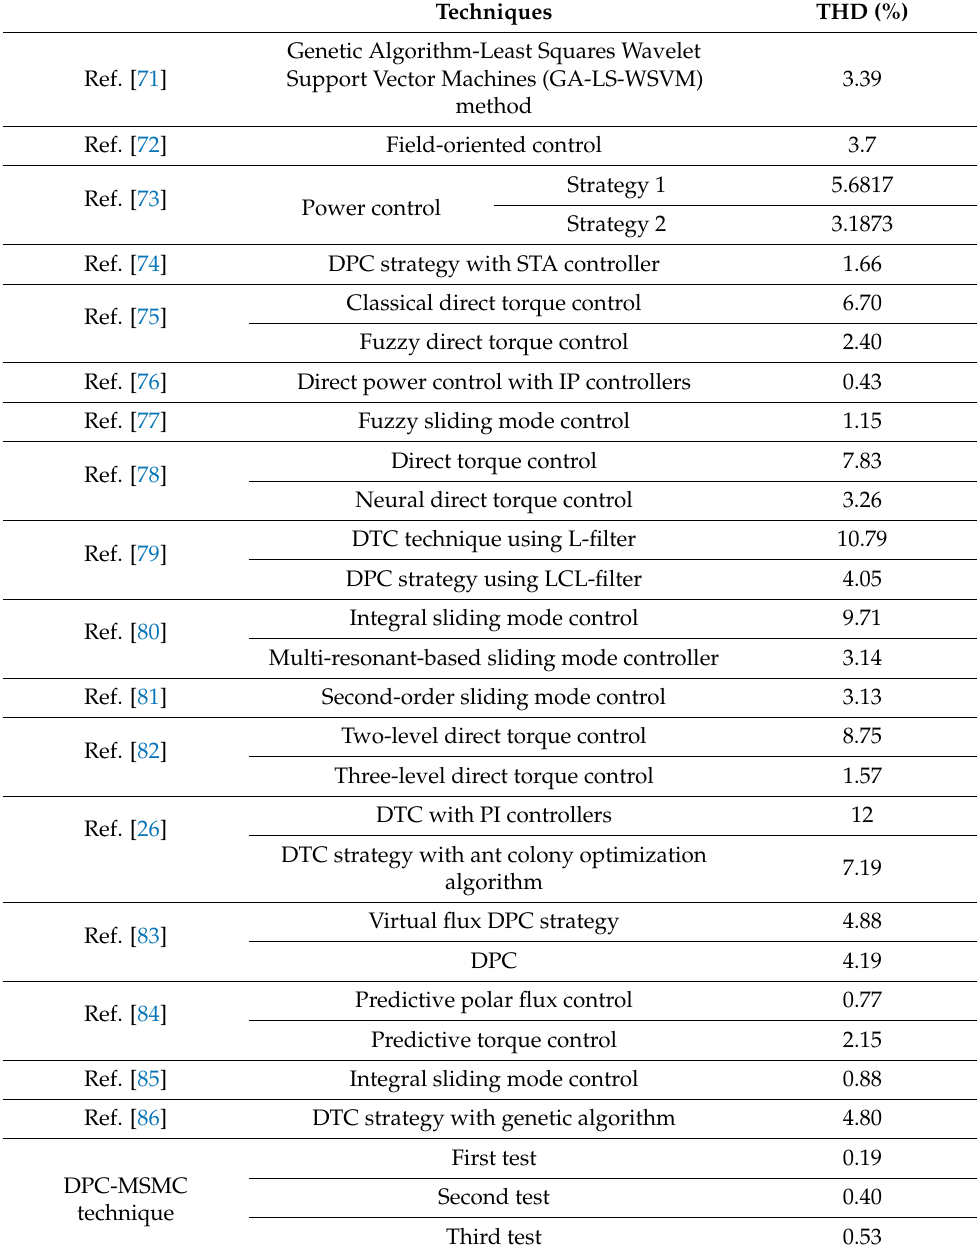
Table 7. A comparative study between the DPC-MSMC technique and other works in terms of the value of